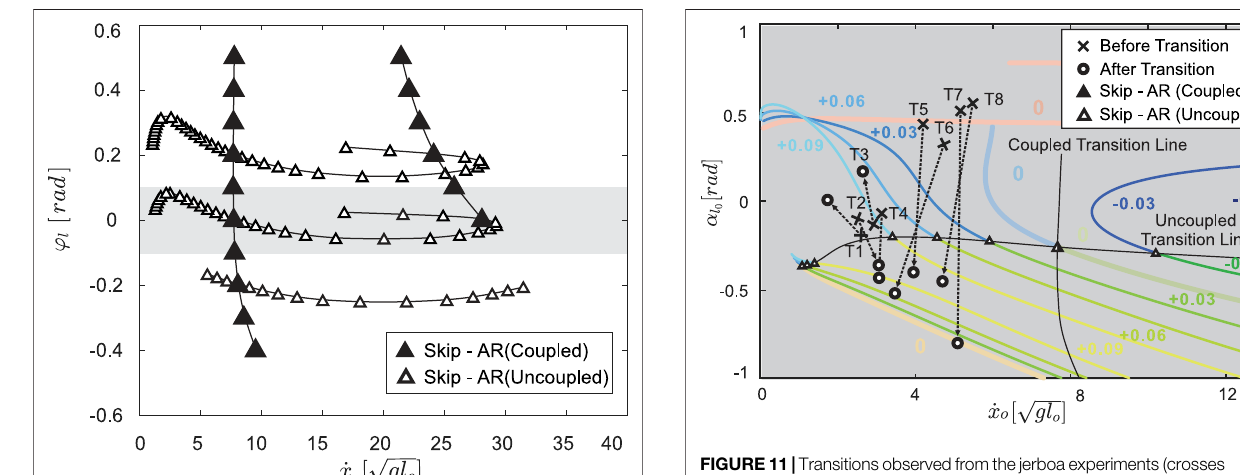
FIGURE11| Transitionsobservedfromthejerboaexperiments(crosses to circles) in comparison to the predicted gait structure in uncoupled models (colored branches and triangles from Figure 9C ) and the predicted transition lines (solid triangles represent coupled transitions and hollow triangles represent uncoupled transitions, the intersection of coupled and uncoupled transitionisshowninhalf-solidandhalf-hollow).Thecrossesindicatetheapex states before the transition, the hollowed circles are the apex state after transition, and the arrows show the transition directions on the Poincaré section. T1to T4 show skip - asymmetrical run (AR) transitions, while T5to T8 show transitions from hopping. The arrows pass through, or near, hollow triangles,showingthatthemodelwiththeuncoupled,ratherthanthecoupled, NLSA mechanism accurately predicts gait transitions that are observed in empirical